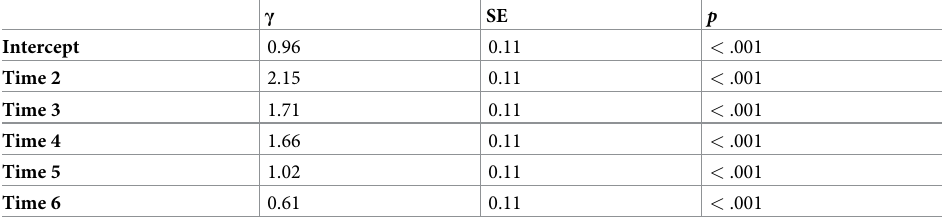
Table 2. Comparing anger at Time 1 to anger at each of the following